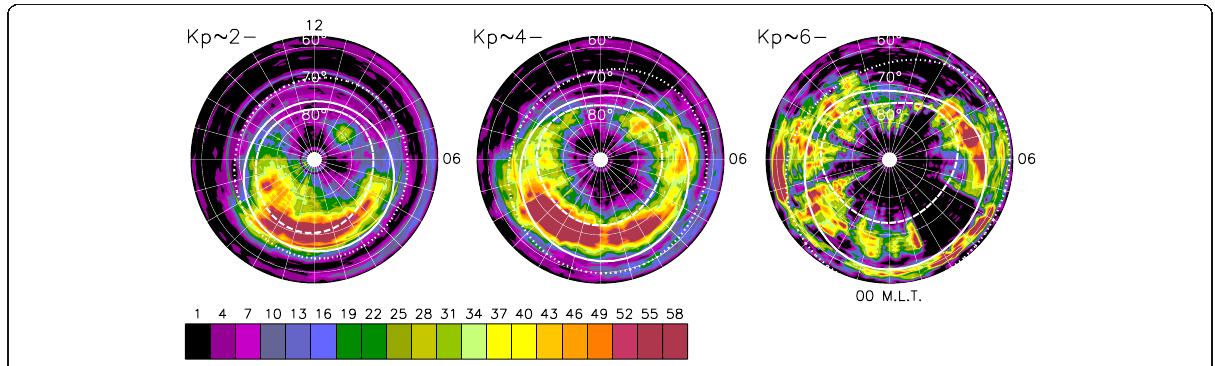
Fig. 16 The occurrence rate (%) of ionospheric echoes from beam 4 of TIG detected during all seasons, and sorted according to geomagnetic activity Kp > 1 to 2; Kp > 3 to 4 and Kp > 5 to 6. Model auroral oval boundaries are superimposed for AL = − 64 nT ( Kp = 2 − ), AL = − 240 nT ( Kp = 4 − ), and AL = − 458 nT ( Kp = 6 − ). Adapted from Fig. 5 of Parkinson et al.